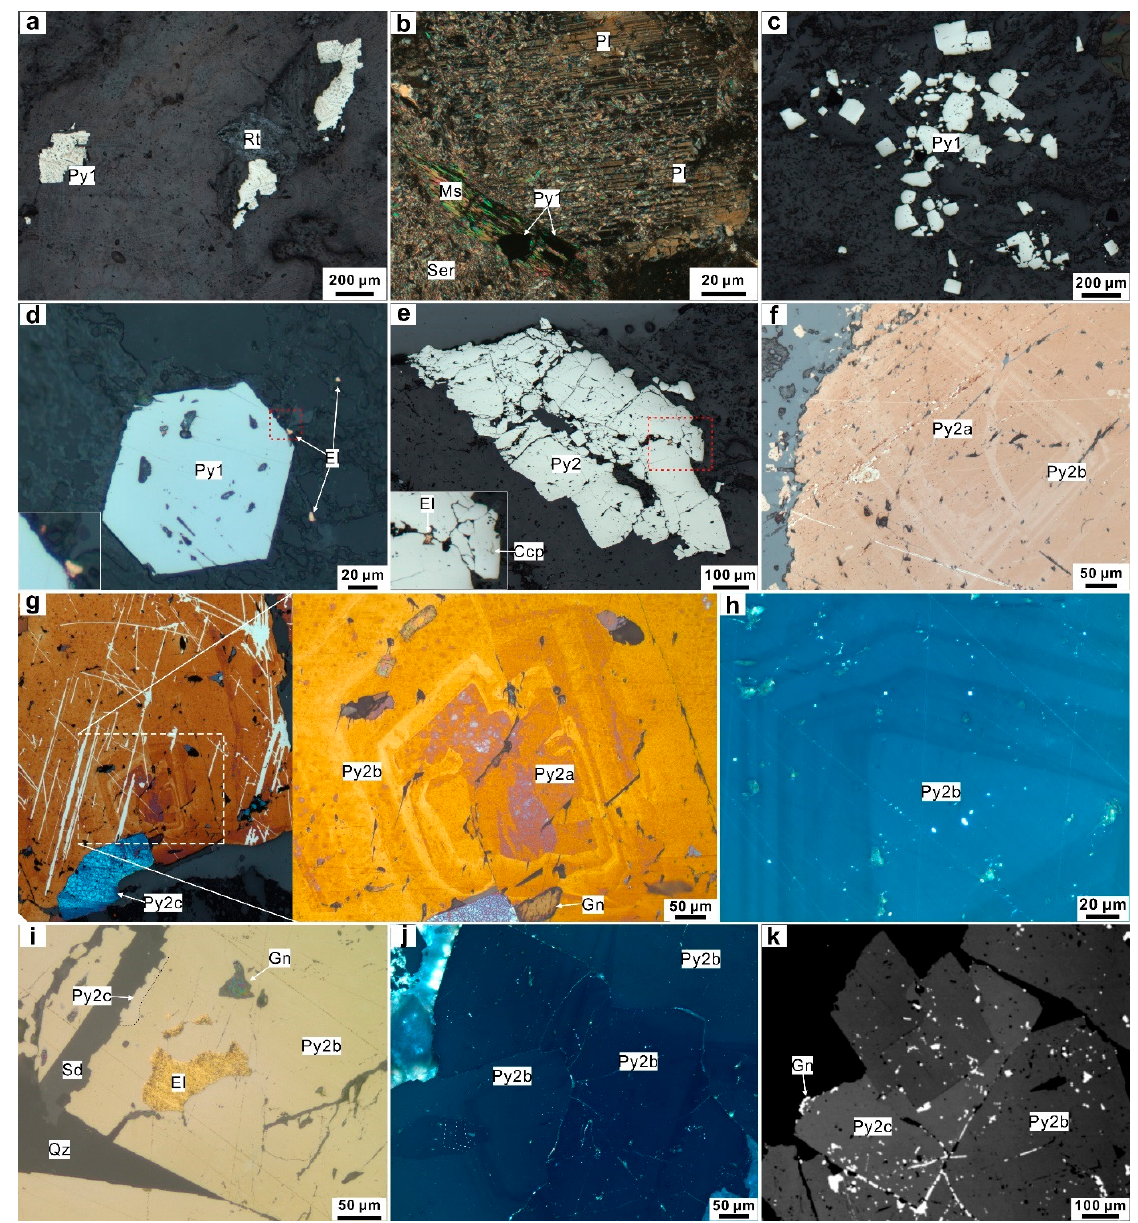
Figure 5. Reflected light ( a , c – g , i ), transmitted plane-polarized light ( b ) and crossed-polarized light ( h , j ) photomicrographs and backscattered electron (BSE) image ( k ) illustrating textures and mineral assemblages of Py1–2 in the Sizhuang gold deposit. ( a ) Earliest pyrite (Py1) as disseminated anhedral to subhedral grains with fine-grained rutile. ( b ) Intergrowth of Py1 and muscovite that totally replaced biotite. ( c ) Medium-grained euhedral to subhedral Py1 clusters in sericite altered rocks. ( d ) Py1 coexisting with free electrum. ( e ) Coarse-grained pyrite aggregates (Py2) associated with quartz vein, in which electrum occurs in the fractures of Py2. ( f ) Early formed pyrite (Py2a) as irregular core overgrowth by zoned pyrite (Py2b). Note the fractured Py2a–b was healed by late pyrite during pyrite growth. (g ) NaClO-etched pyrite showing the formation sequence of several subtypes of Py2. The As-rich Py2c and galena are more susceptible to NaClO. Note the straight white line is caused by wiping rather than etching. ( h ) Py2b with the oscillatory zoning texture. ( i ) Py2b intergrown with electrum and galena and overgrown by Py2c with relatively white reflected-color (As-rich). ( j ) Py2 commonly underwent fracture-growth processes. ( k ) Py2c showing a lighter color in BSE images. Galena often occurs in the pyrite fractures or as filling into Py2. Ccp: chalcopyrite; El: electrum; Gn: galena; Ms: muscovite; Rt: rutile; Sd: siderite; Pl: plagioclase; Py: pyrite; Qz: quartz.